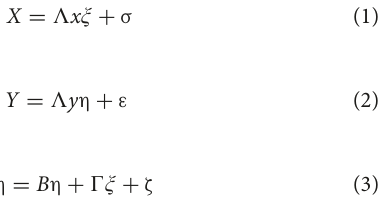
algorithm accuracy. R 2 around 1 indicates a stronger